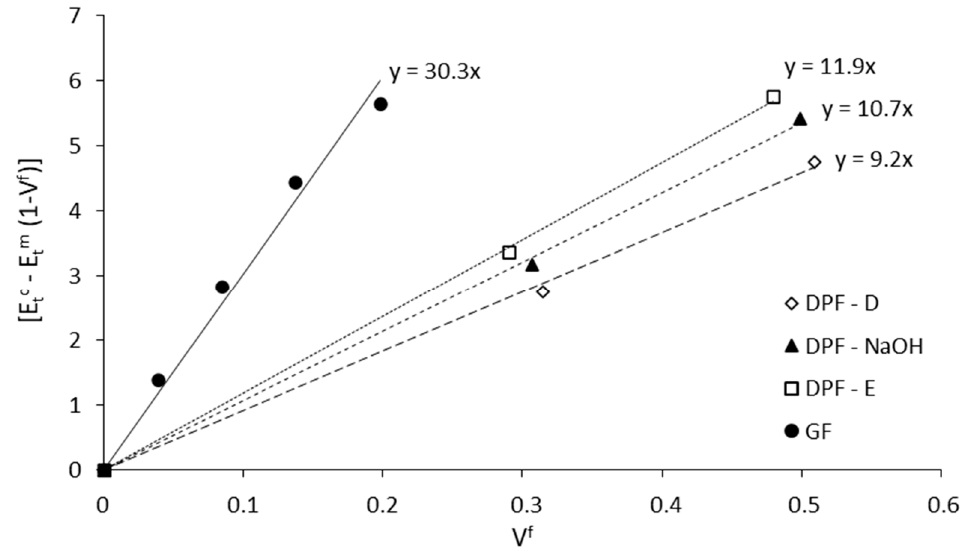
Figure 7. Net contribution of the reinforcements to the stiffness of the composites.